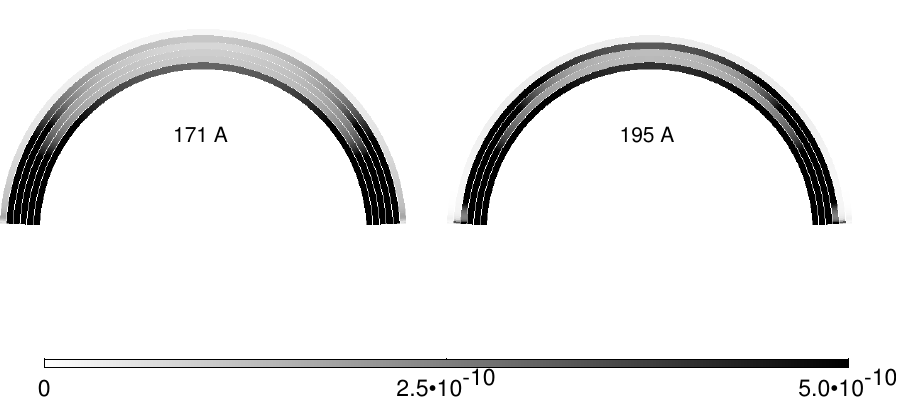
Figure 13: Emission in two TRACE filterbands predicted by a model of loop made by several thin strands. Image reproduced with permission from Reale and Peres (2000), copyright by